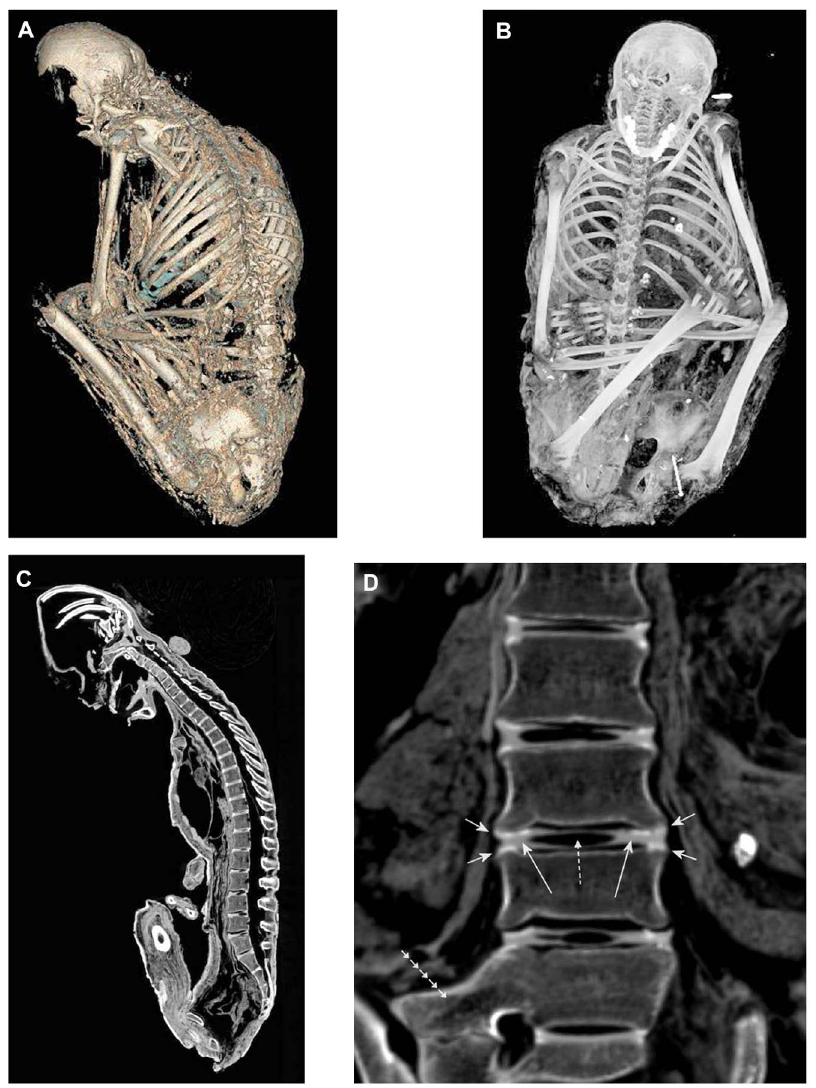
Figure 2. Paleoradiology – The skeleton of the mummy. ( A ) Three dimensional reconstruction and ( B ) maximum intensity projection of the complete mummy giving an overview on the skeleton. ( C ) Sagittal CT reformation image showing the untouched spine and the preservation of thoracic and lumbar intervertebral discs. ( D ) Coronar CT reformation image of the lumbar spine demonstrating incomplete fusion of the apophyses of the lumbar vertebrae (short arrows). The preserved intervertebral discs reveal the outer annulus fibrosus (long arrows) as well as the inner nucleus pulposus that is now replaced by air (dotted arrow). Exemplary inscription of the segment between the third and fourth lumbar vertebra. Constitutional segmentation defect with fusion of the fifth lumbar vertebra and the sacrum on the right side (arrow